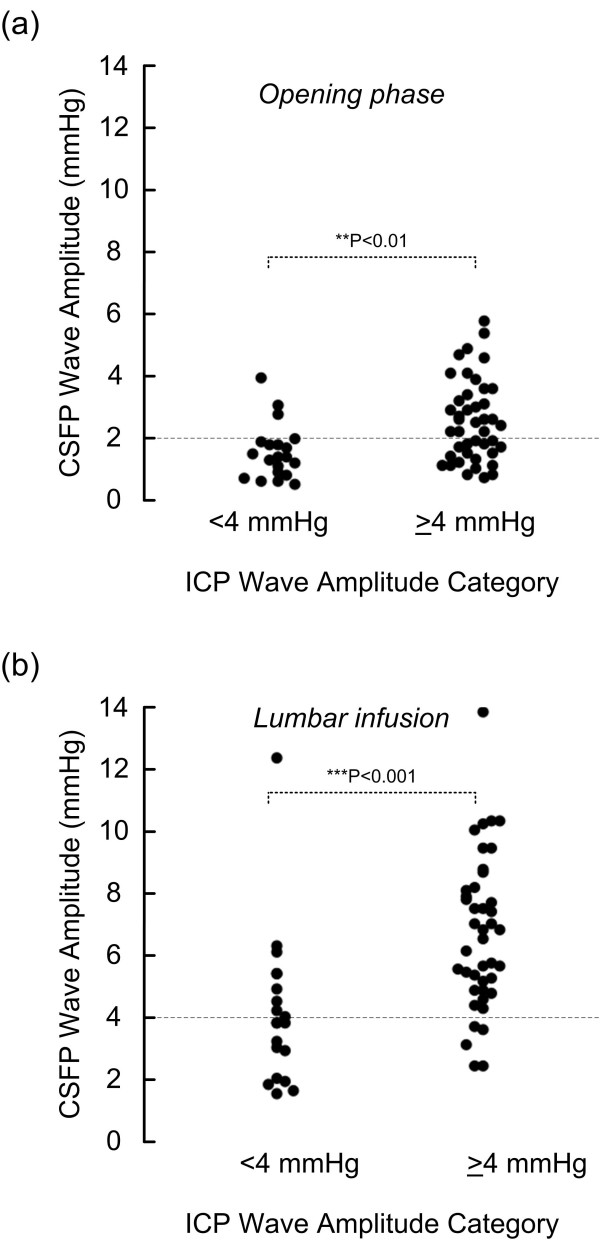
Scatter plots of CSFP wave amplitude during the opening period and during lumbar infusion for the two categories of over-night pulsatile ICP (mean ICP wave amplitude either < 4 mmHg or ≥ 4 mmHg during the period 11 p.m. to 7 a.m.) a) Shows the pulsatile CSFP (mean CSFP wave amplitude) during the opening phase after lumbar puncture, and (b) during the phase of lumbar infusion (15 ml over 10 min; 1.5 ml/min). Dotted lines denote different targets for CSFP wave amplitude during the opening period and during lumbar infusion. Significant differences between groups were tested with one-way ANOVA.